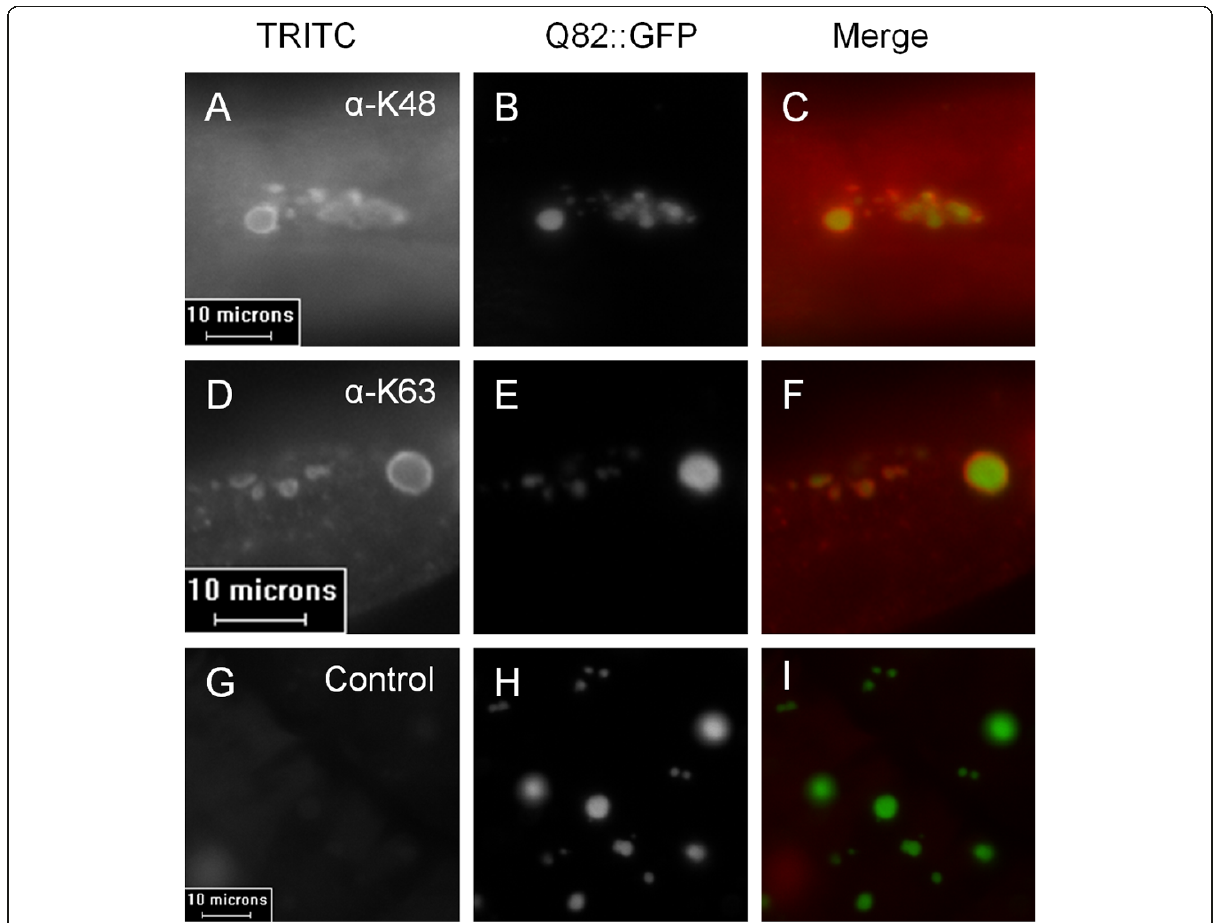
Figure 4 Q82::GFP aggregates contain both K48- and K63-linked polyubiquitin chains . Synchronized adult worms were fixed and probed with antibodies specific for K48 or K63 polyubiquitin chains. Secondary antibody was conjugated to TRITC ( A , D , and G ). Aggregates were visualized via GFP fluorescence ( B , E , H ). Control samples ( G ) received the same treatment, without primary antibody. Merged images ( C , F ) show colocalization of K48- or K63-linked polyubiquitin chains to aggregates, but not when the primary antibody is omitted ( I